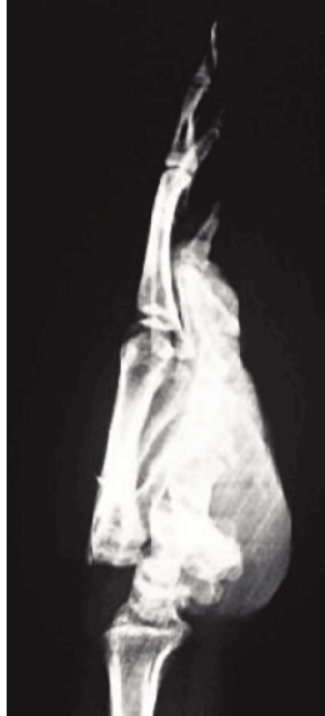
Lateral radiograph showing Classification Type B. Volar Fig. 2: dislocation of index and middle finger metacarpals without any associated fractures.